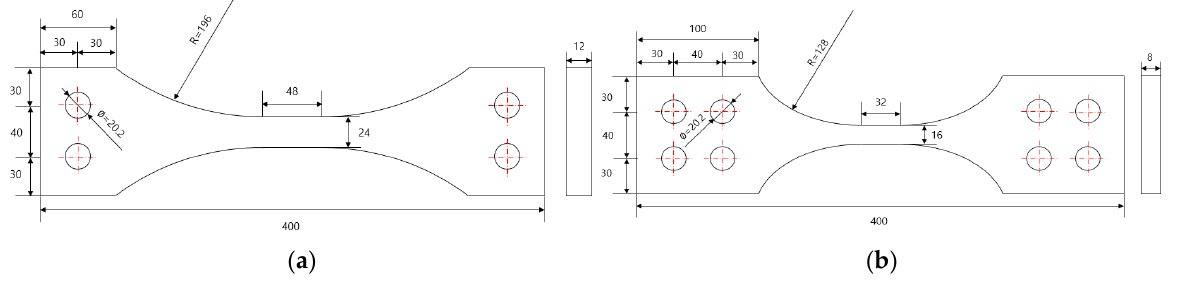
Figure 5. Detailed dimensions of fatigue test specimens: ( a ) high Mn; ( b ) 9% Ni.